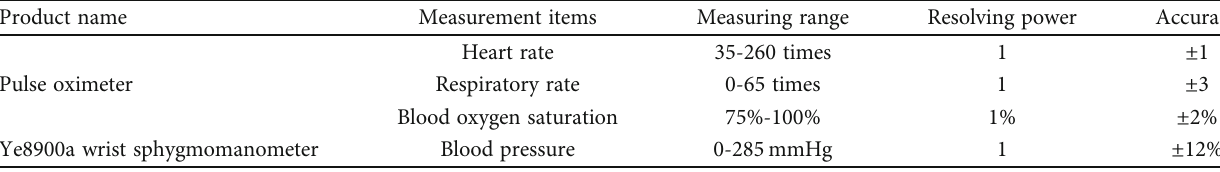
Figure 9: Comparison results of health status assessment. Table 3: Main performances of two evaluation models.